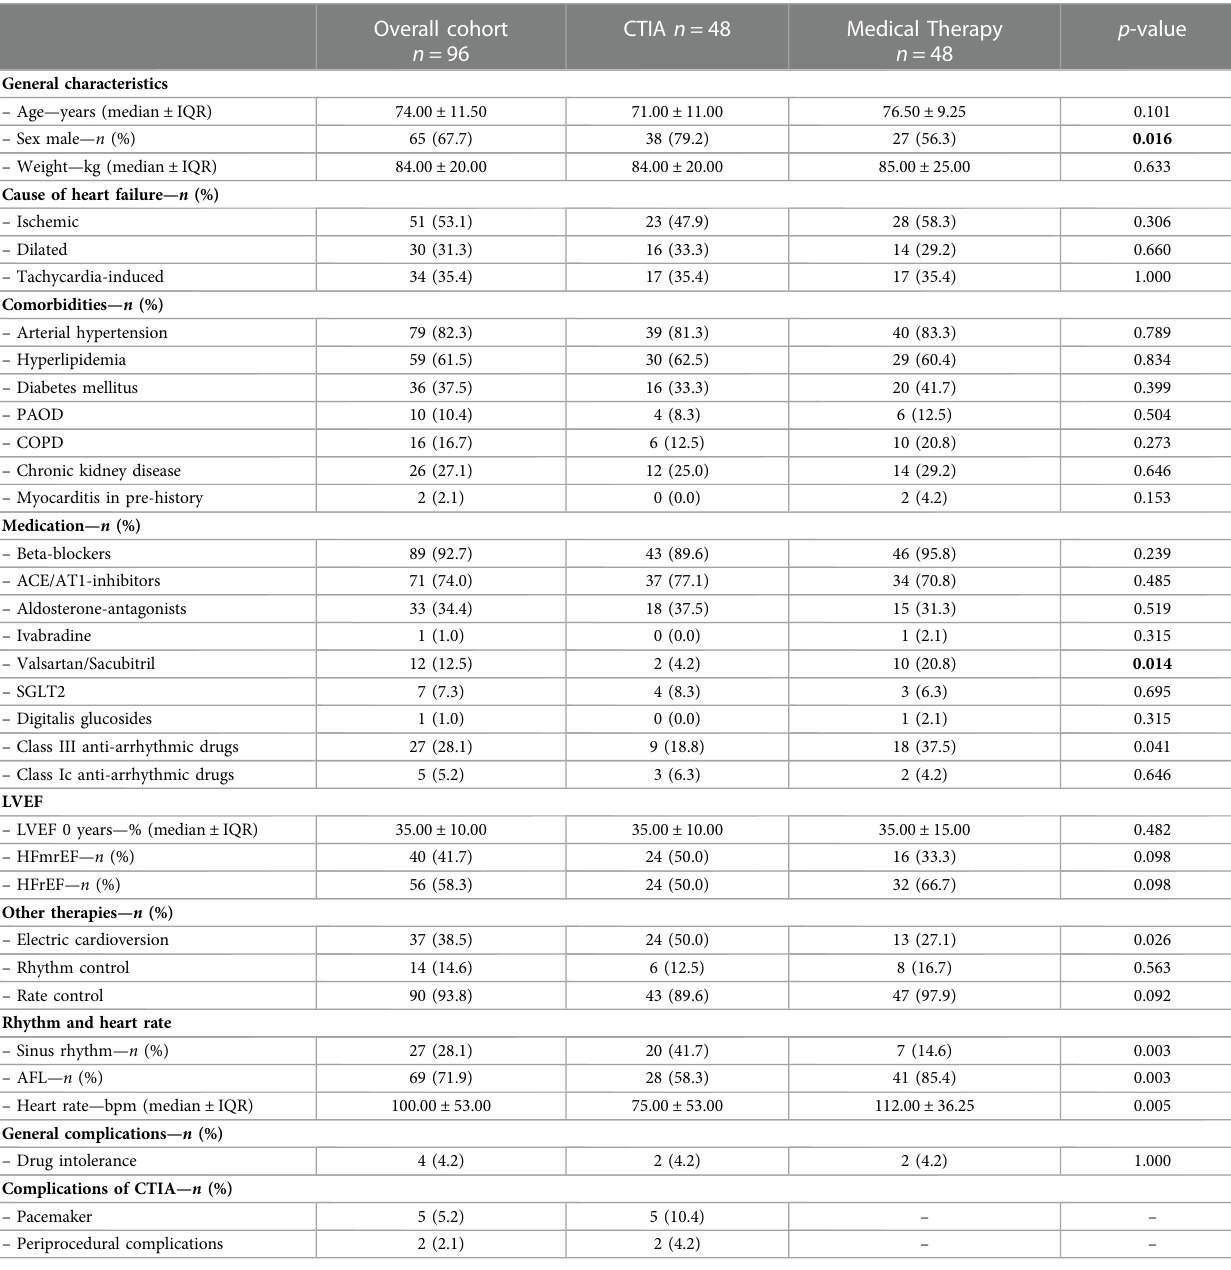
TABLE 1 Baseline characteristics of overall cohort and different study groups (CTIA group vs. medical therapy